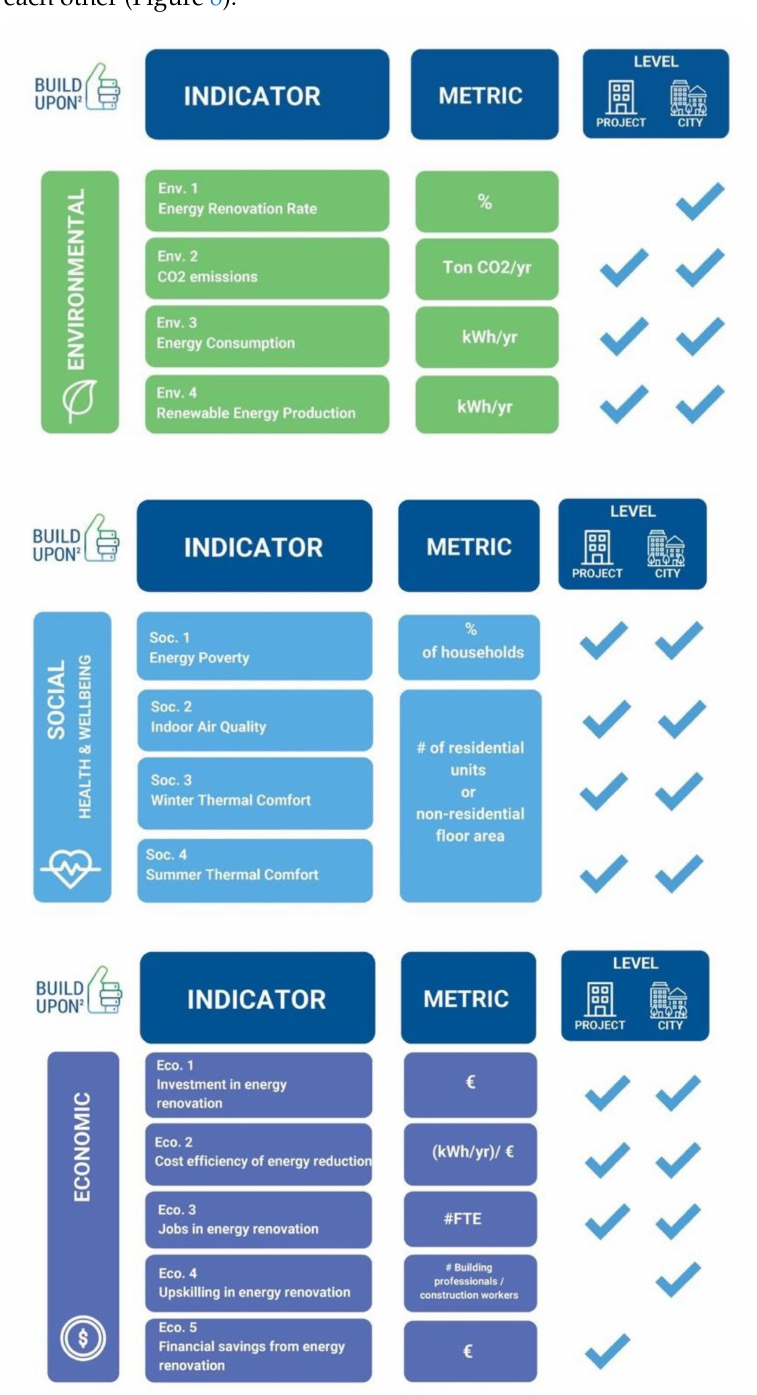
Figure 8. Methodology of core indicators proposed for the reporting and monitoring of the Build Upon Energy Renewal Framework